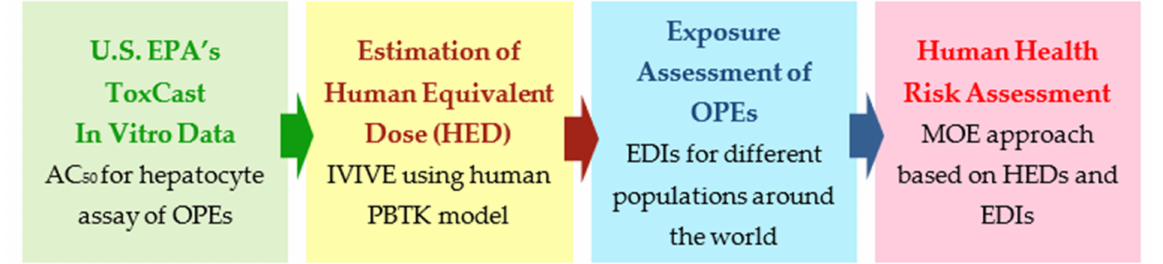
Figure 1. Workflow for risk